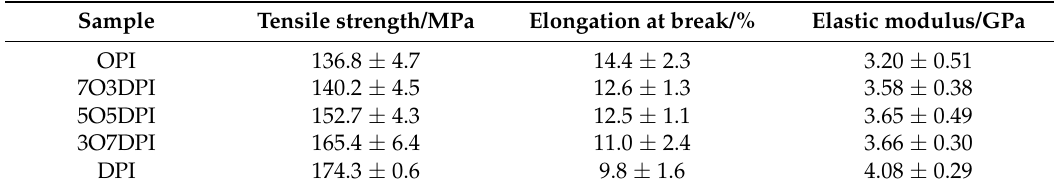
Table 3. Mechanical properties of the polyimide films.